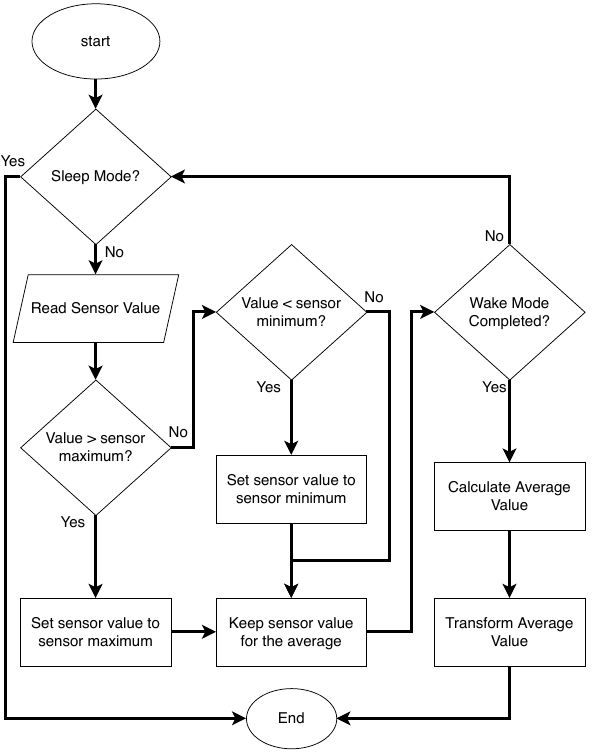
Figure 4. Sensor flowchart. Each sensor runs through SleepMode and WakeMode. The sensor only executes a sleep-wait in the SleepMode. The sensor loops to obtain sensor values and calculates the average when the WakeMode is